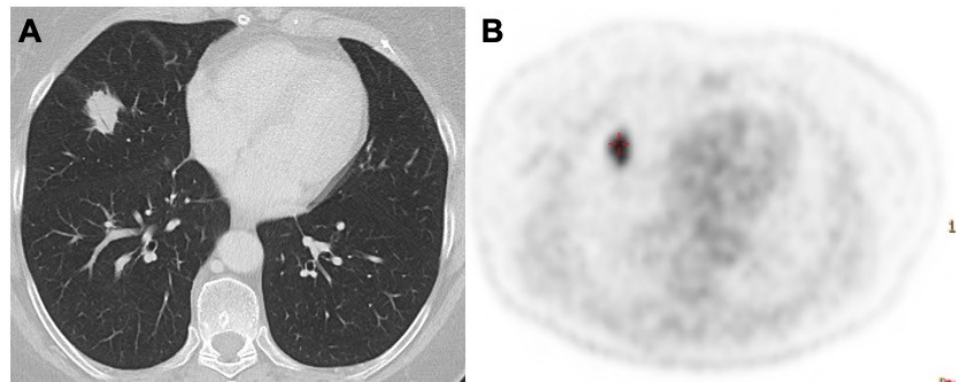
Figure 2. Lung nodules in the medium lobe ( A ). The PET scan in ( B ) shows a high captation of 18FDG, a high suspicion for primary lung cancer. Biopsy revealed primary MALT lymphoma of the lung.